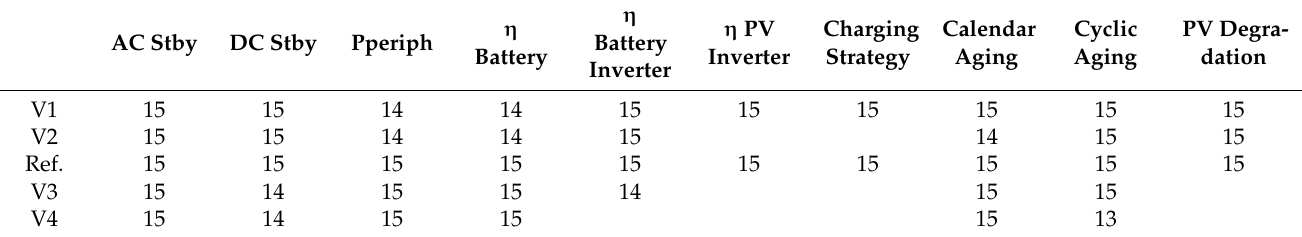
Table 6. PV system size of the most economic combination of the different simulation runs with the different technical